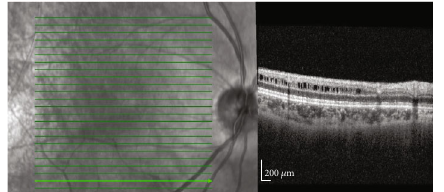
Figure 5: SD-OCT of the right eye demonstrating the resolution of subretinal fl uid seen in Figure